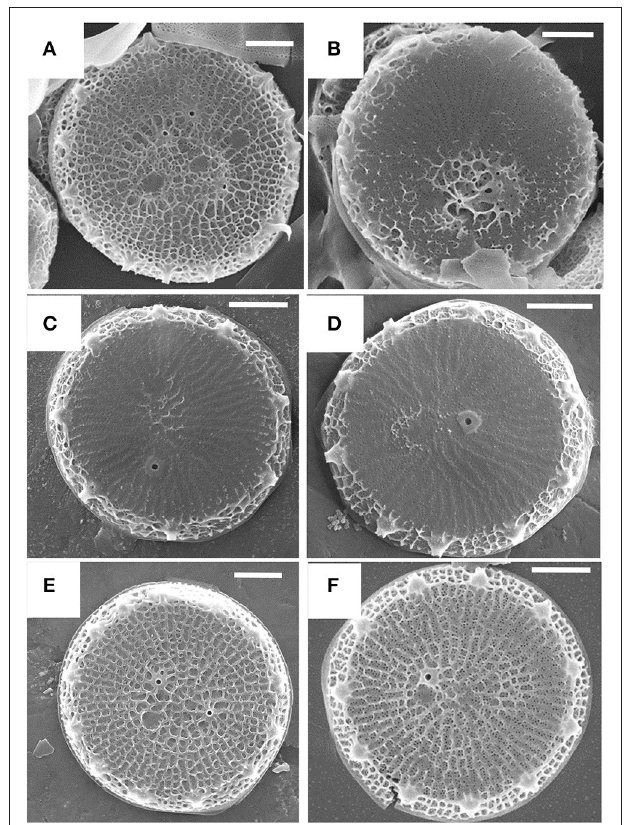
FIGURE 7 | Alterations in T. pseudonana valve structure resulting from antisense knockdowns of TpSAP1 (A,B) and TpSAP3 (C,D) . Wild-type controls are (E,F) . From Tesson et al. (2017), reproduced under the Creative Commons